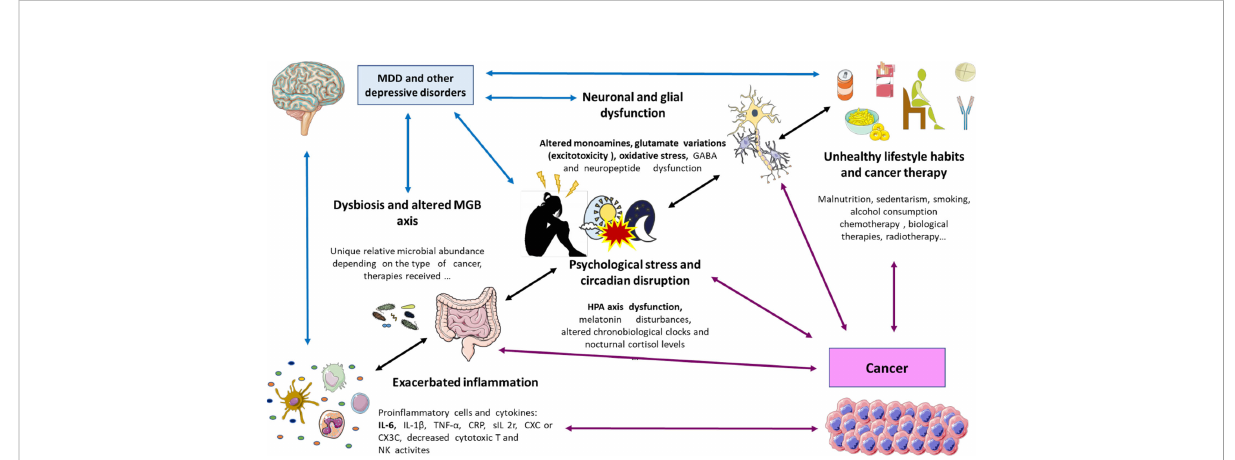
FIGURE 1 A global perspective on the biological links between cancer and depression. As shown, there are plenty of factors that are interrelated including an exacerbated in fl ammation (prominently due to augmented proin fl ammatory cells and cytokines like IL-6); dysbiosis (with different microbial pro fi les) and disrupted microbiota gut brain (MGB) axis; psychological stress and circadian disruption (prominently through HPA disruption, changes in melatonin, nocturnal cortisol, and circadian clocks); neuronal and glial dysfunction (changes in neuropeptides and neurotransmitters like monoamine metabolism, glutamate, and GABA); unhealthy lifestyle habits like smoking, malnutrition, and sedentarism; and the proper cancer therapy. IL, interleukin; MGB axis, microbiota – gut – brain axis; HPA axis, hypothalamic – pituitary – adrenal axis; GABA, gamma aminobutyric